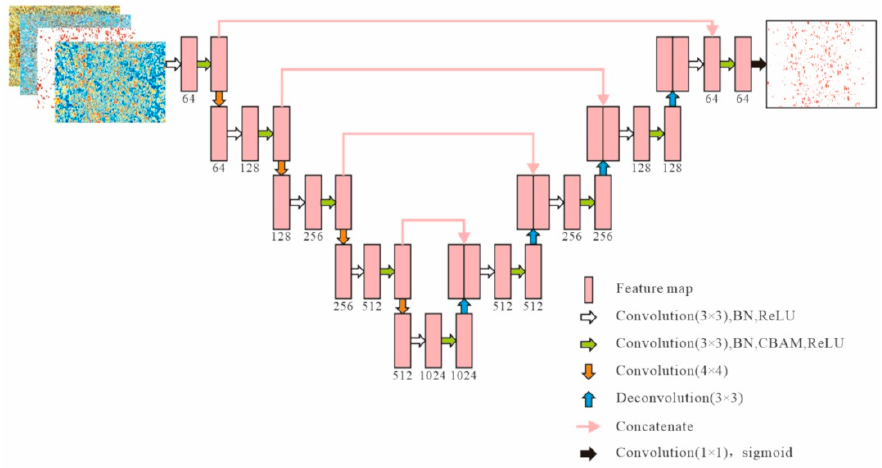
Figure 5. Schematic diagram of DAF-U-Net model. DAF-U-Net is a neural network model with seismic diffraction attributes as input and underground fracture distribution as output, mainly composed of an encoder and decoder. There is only a convolution layer, a nonlinear activation function layer, and a pooling layer in the network structure, and there is no full connection layer.